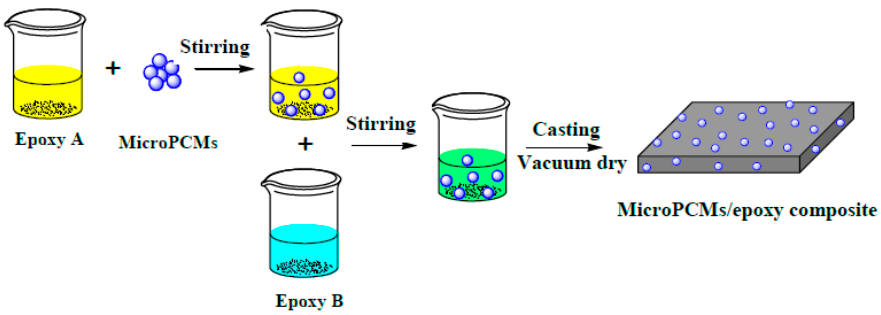
Figure 5. Schematic diagram of the fabrication of MicroPCMs/epoxy composites by a casting method.